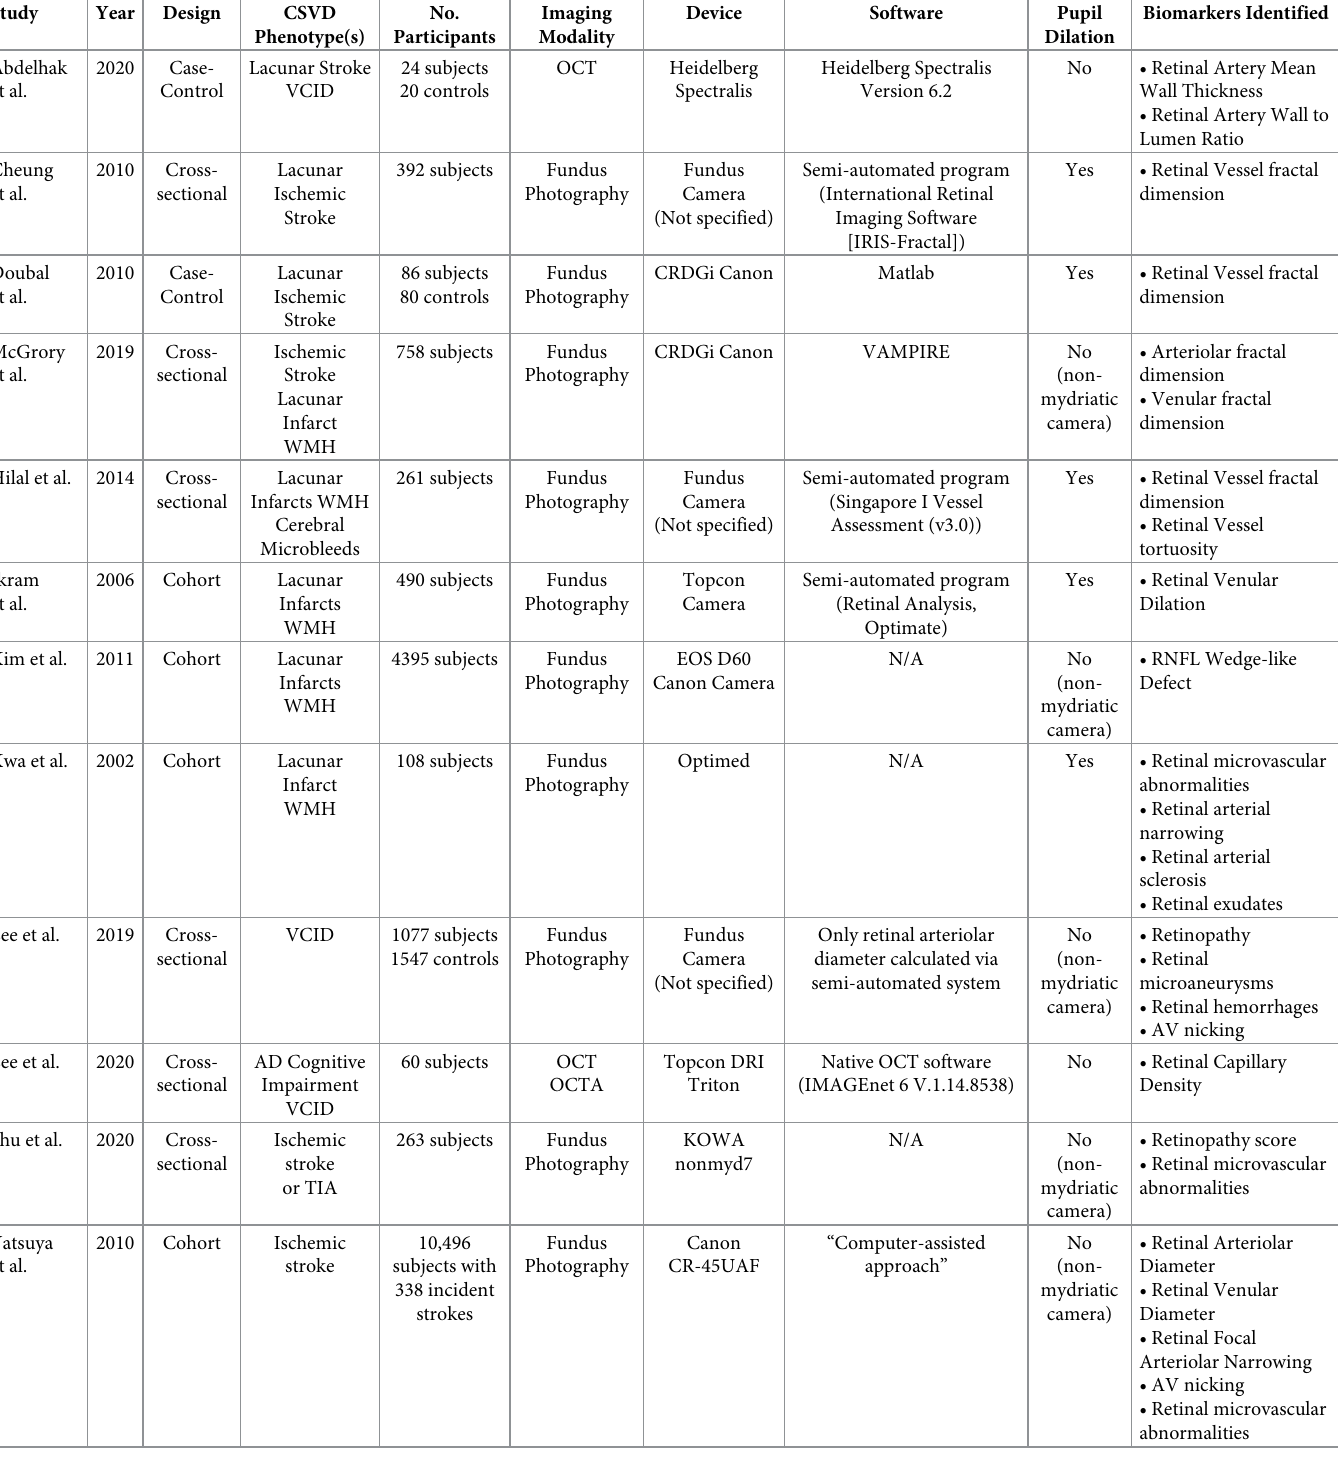
Table 3. Summary of design, patient characteristics, methodology and results for studies of sporadic